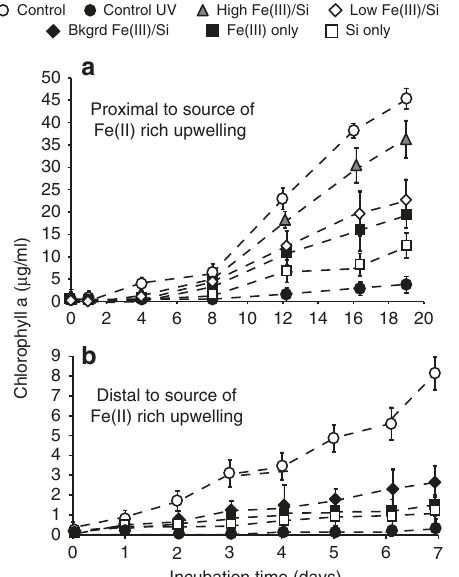
Fig. 1 Growth rates of UV-C irradiated Synechococcus cultures. Cultures were irradiated at an exposure of 500 J/m 2 in Fe(III)- and Si-supplemented media relative to irradiated (dark circle: control UV) and un-irradiated (white circle: control) cultures in un-supplemented growth media. a Fe(III) concentrations representing environments proximal to a source of iron-rich upwelling. White diamond: low Fe(III)/Si, 0.15/0.6 mM; gray triangle: high Fe(III)/Si, 0.55/2.0mM; white square: Si only, 2.0 mM; black square: Fe(III) only, 0.35 mM. b Fe(III) concentrations (0.04 mM) representing environments located distally from a source of iron-rich upwelling (i.e., background concentrations for Archean seawater 25 ). Black